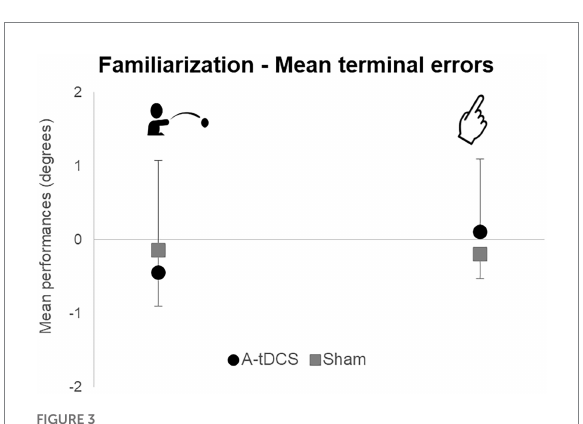
FIGURE 3 Mean group terminal errors during familiarization. Mean group terminal errors are represented with standard deviations for each group (A-tDCS group in black, Sham group in grey) and for each task (pointing on the right, throwing on the left).